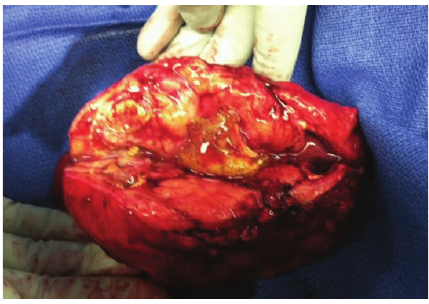
Figure 3: Intraoperative photograph of left XGP